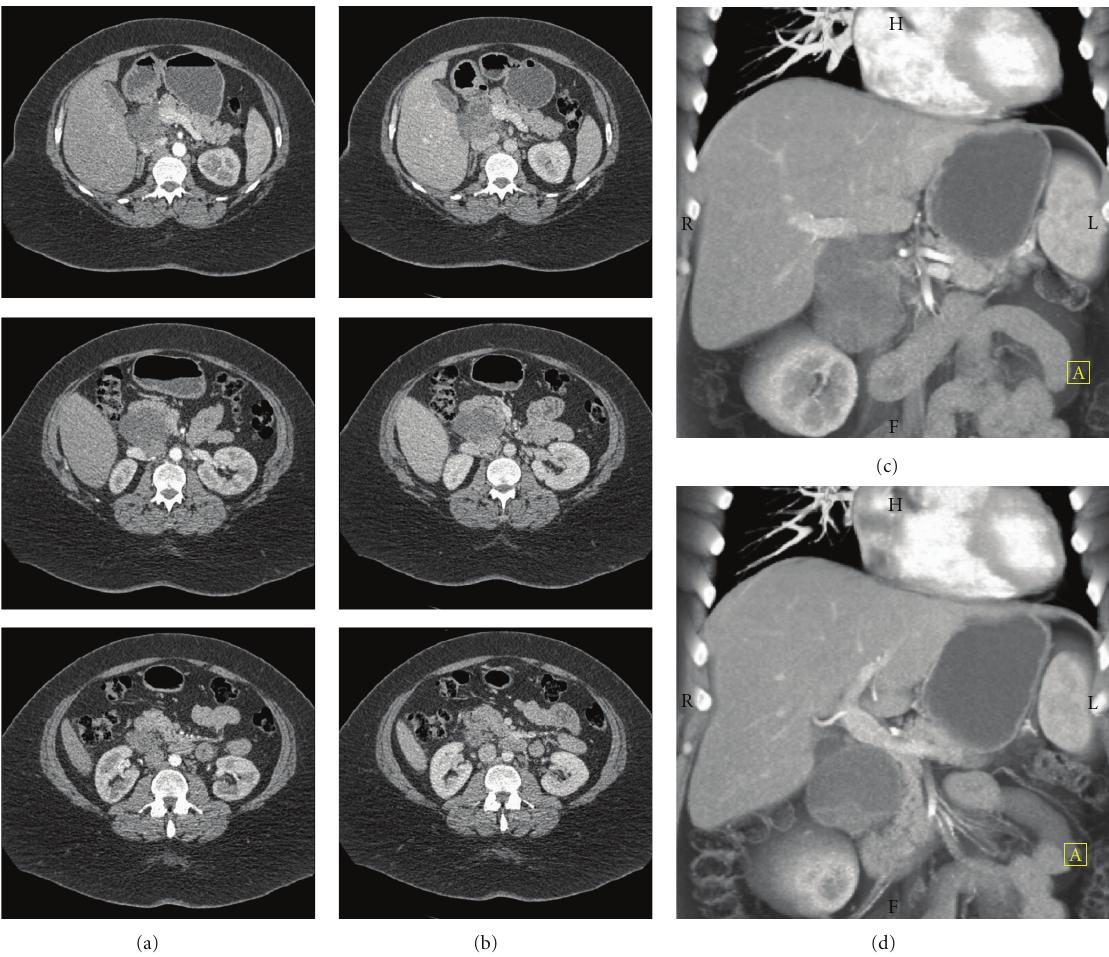
Figure 1: Abdominal CT scan with IV contrast demonstrating a cystic mass in the head of the pancreas. (a) Arterial phase, (b) venous phase, (c) three dimensional coronal CT reconstruction of the celiac axis illustrating resectability, and (d) three dimensional CT reconstruction of the porta